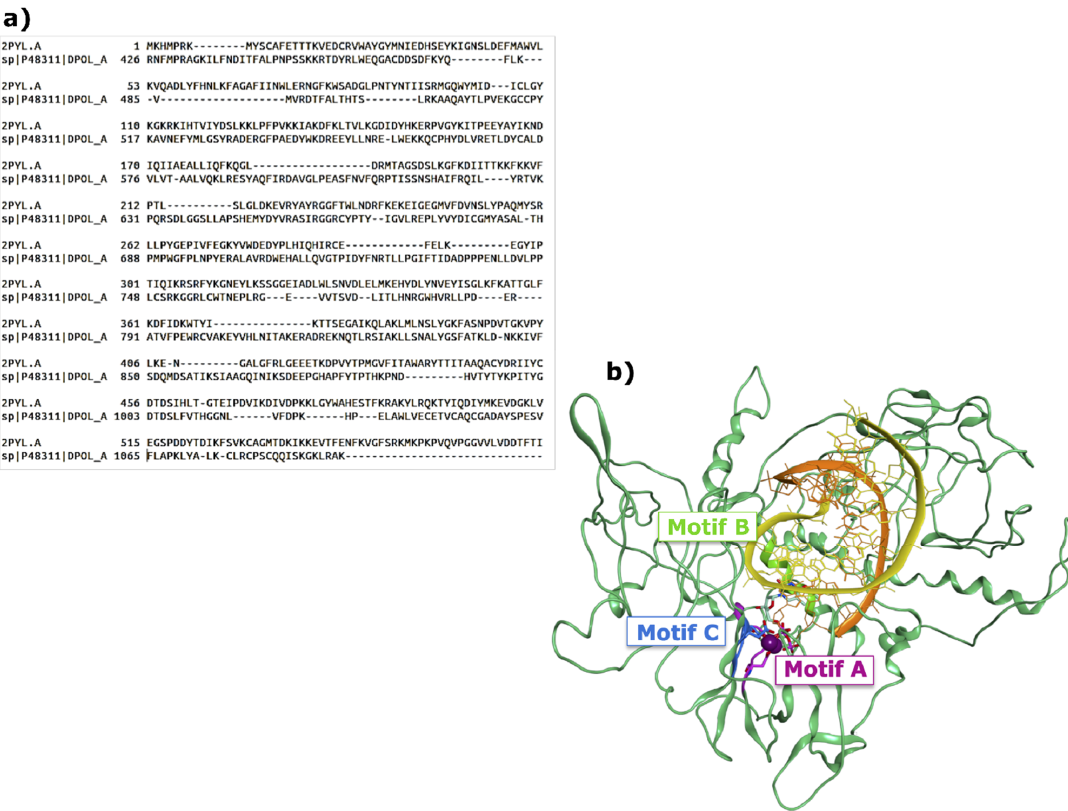
Figure 4. ( a ) Sequence alignment between the bacteriophage f29 DNA polymerase and the polymerase domain of HAdV F serotype 40; ( b ) final model for the AdV Pol, including the nucleic acid and NTP components minimized from the template.